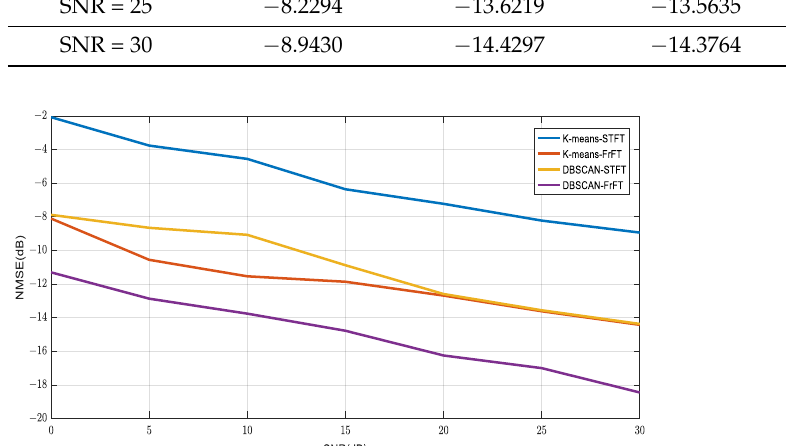
Figure 13. Compariso n of estimation accuracy of mixed matrix with different SNRs (30